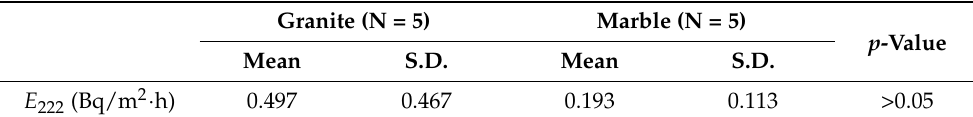
Table 1. The results of radon exhalation rates from building materials.